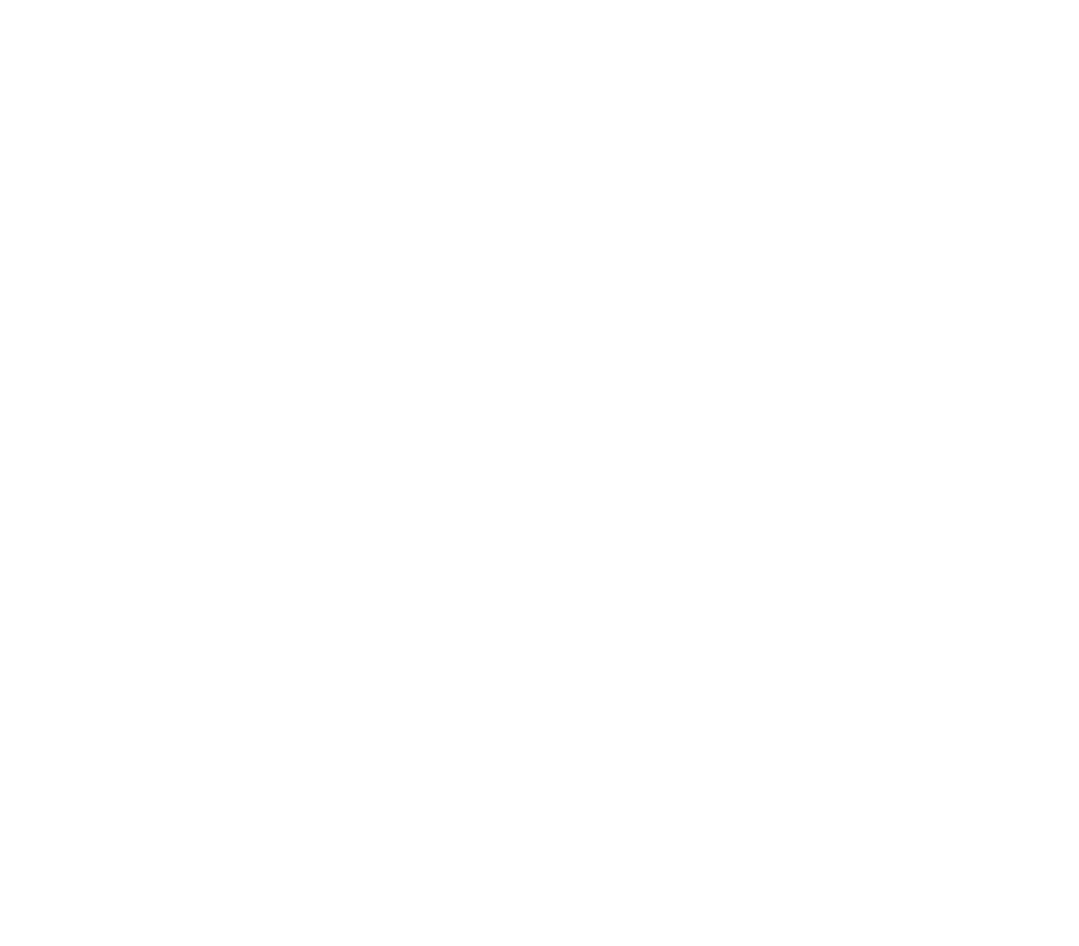
Table 2. Factors associated with risk of sarcopenia estimated by univariate ordinal logistic regression analysis (N =